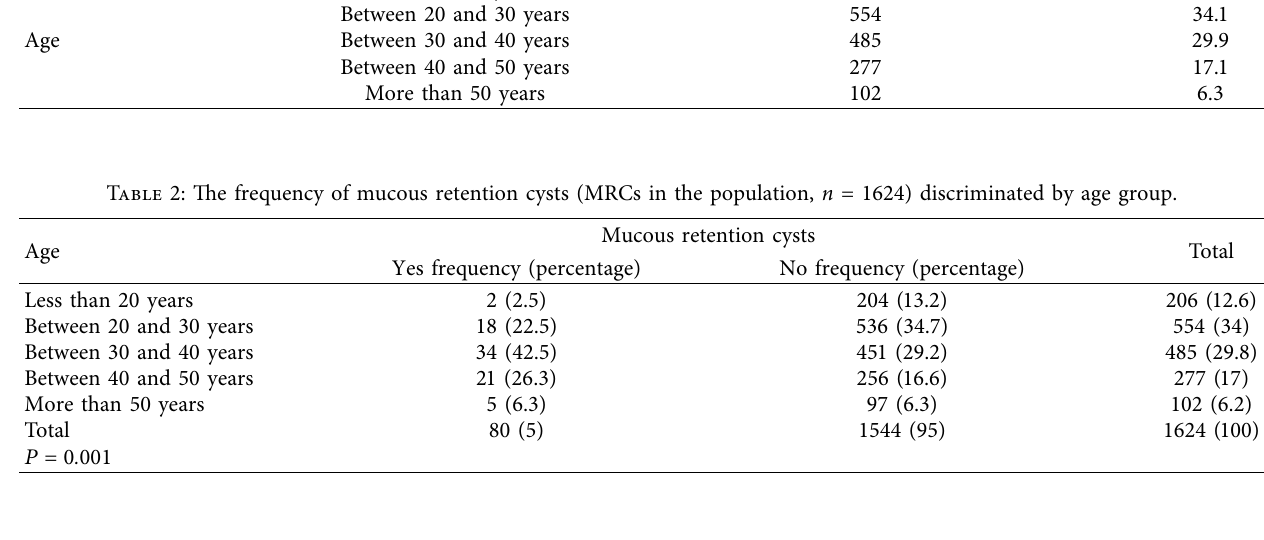
Table 1: The demographic information of the population studied. Frequency Percentage